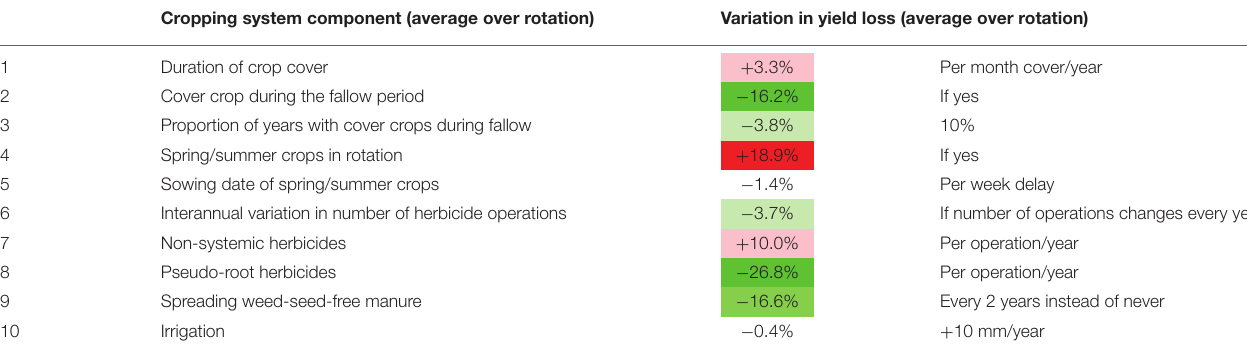
TABLE 4 | Effect of management practices on the resilience (variation in yield loss) of cropping systems to tillage suppression. Cropping system component (average over rotation) Variation in yield loss (average over